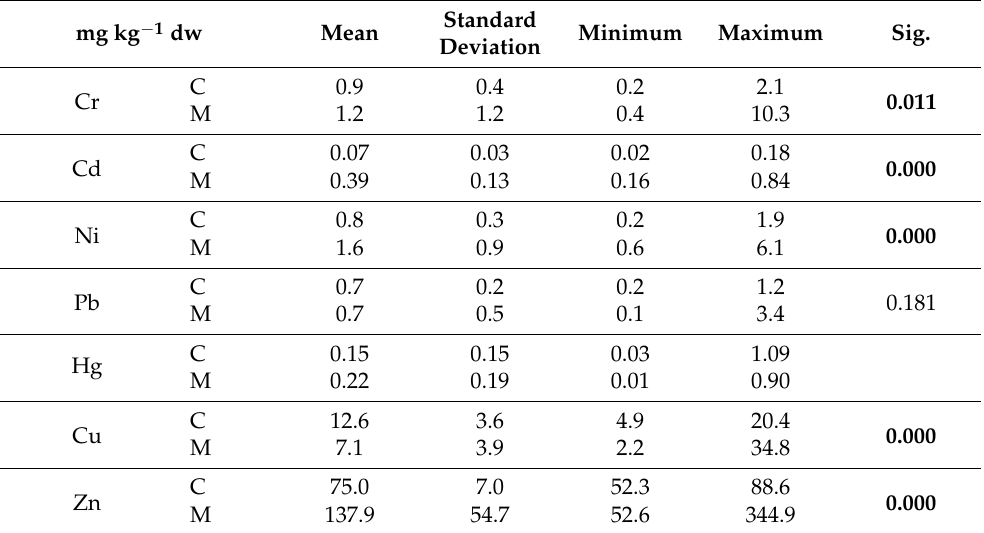
Table 5. Statistical parameters for the measured heavy metals in biota, differentiating between clams (C) vs. mussels (M) in all the studied water